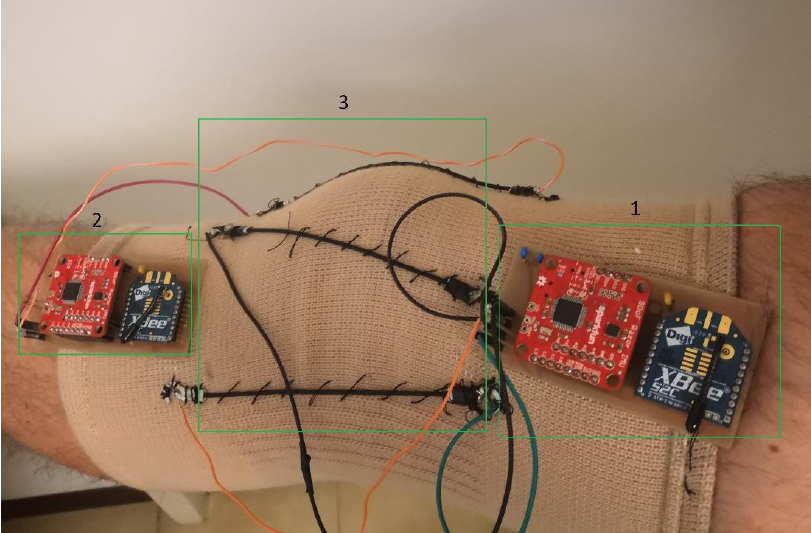
Figure 1. Smart left knee brace for dynamic knee laxity measurements. (1) Femoral unit (IMU, microcontroller, transceiver, and front-end for stretch sensors); (2) Tibial unit (IMU, microcontroller, transceiver, and front-end for stretch sensors), (3) three stretch sensors.